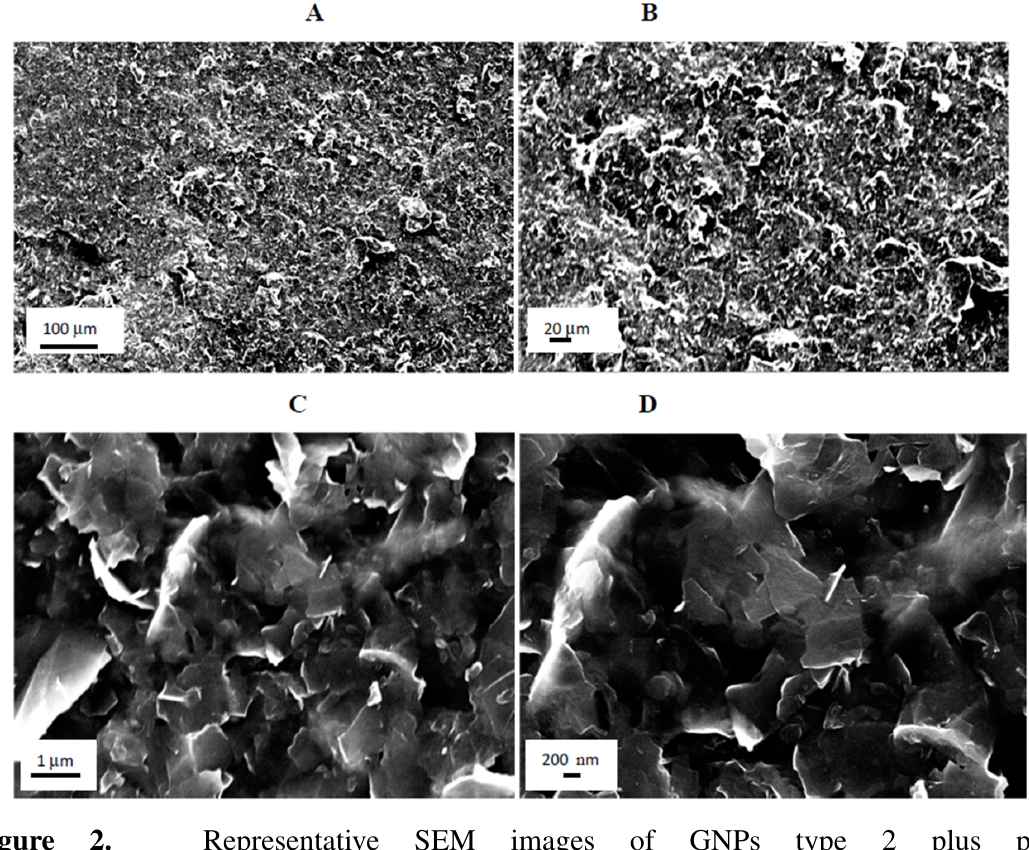
Figure 2. Representative SEM images of GNPs type 2 plus poly (3,4-ethylenedioxythiophene) poly(styrenesulfonate) (PEDOT:PSS) composite film/CE, ( A , B ) panels show SEM images of surface; ( C , D ) panels shows SEM of fractured edge of the composite film/CE.